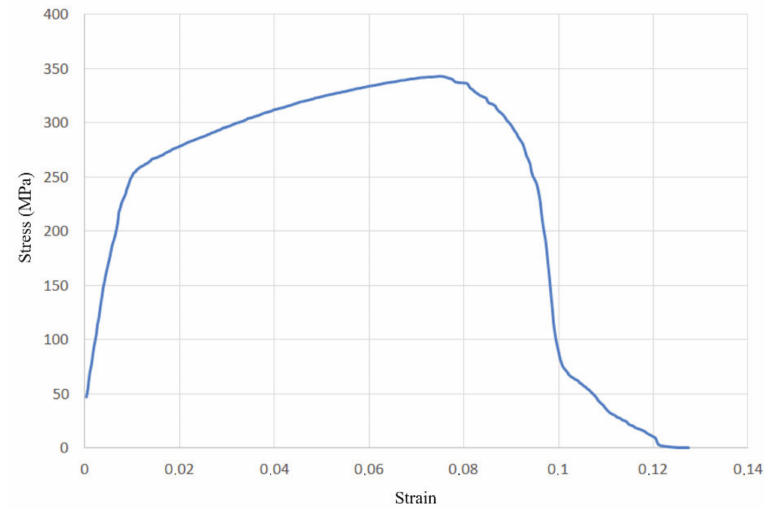
Figure 17. Stress–strain diagram for the group with WM sagging and incomplete root penetration (group III).